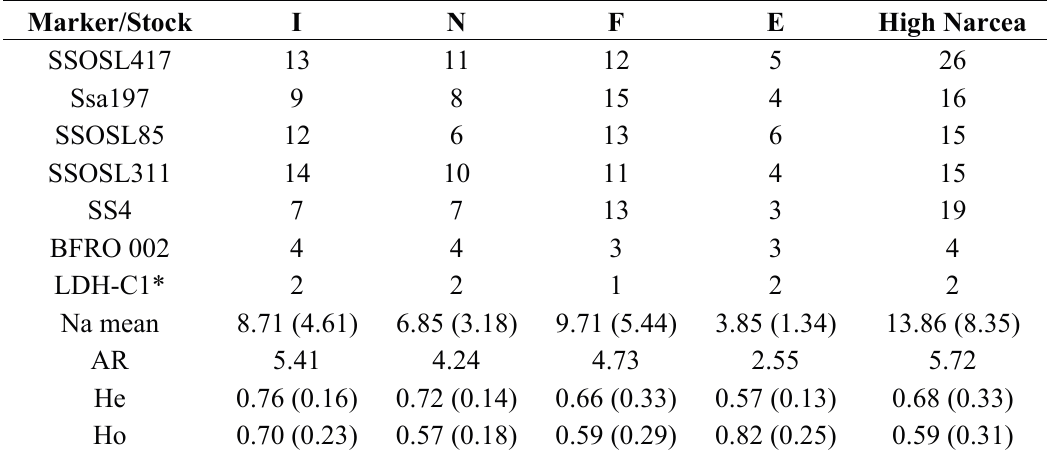
Table 3. Genetic variability at microsatellite loci studied by the number of alleles per locus for each population (Na), allelic richness (AR), and expected and observed heterozygosity (He and Ho, respectively); standard deviation (SD) is shown between brackets.